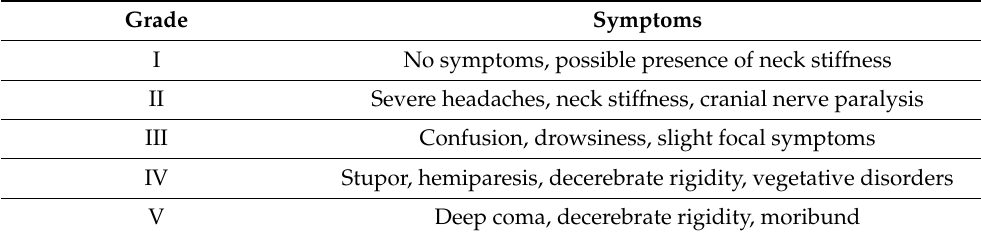
Table 1. Classification of the severity of subarachnoid hemorrhage.